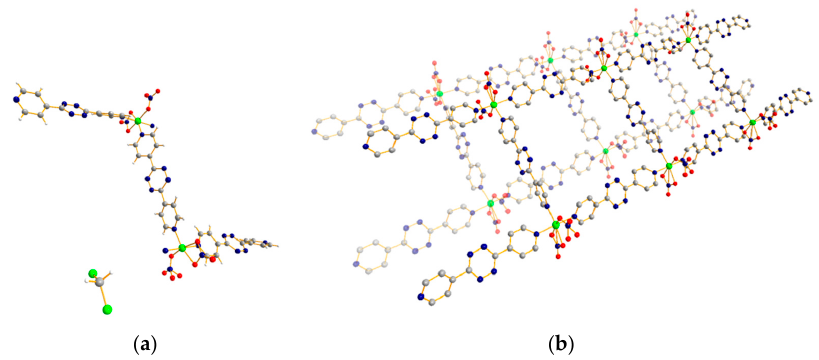
Figure 2. ( a ) Unit Structure of [Ni(pytz) 1.5 (NO 3 ) 2 ]· n DCM ( n = 2–3); ( b ) 1D ladder structure; Ni ( green ), C ( grey ), H ( white ), N ( blue ), O ( red ). DCM and ligand H atoms omitted for clarity in ( b ).